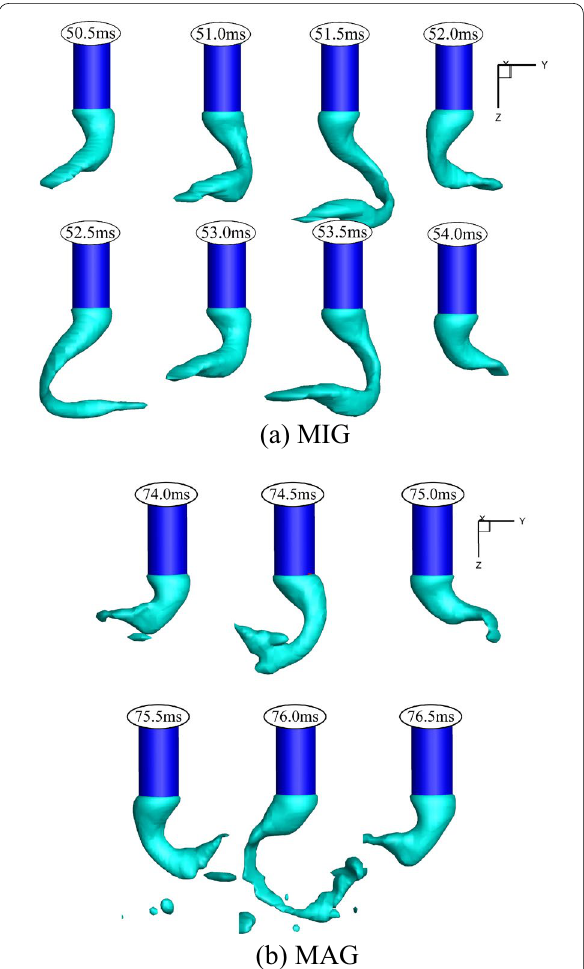
Figure 3 The metal transfer processes of 500 A MIG and